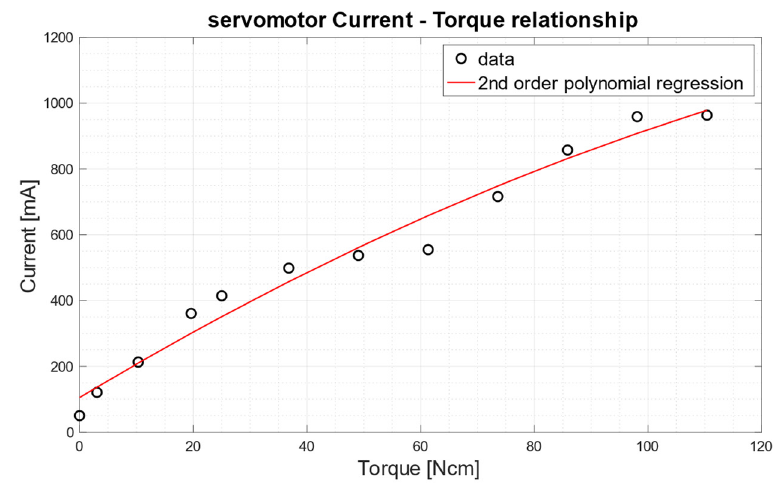
Figure 11. Relationship between the current absorbed by the servomotor (measured in mA) and the torque generated by it (measured in N·cm). The second-order polynomial regression function is depicted as a red continuous line.